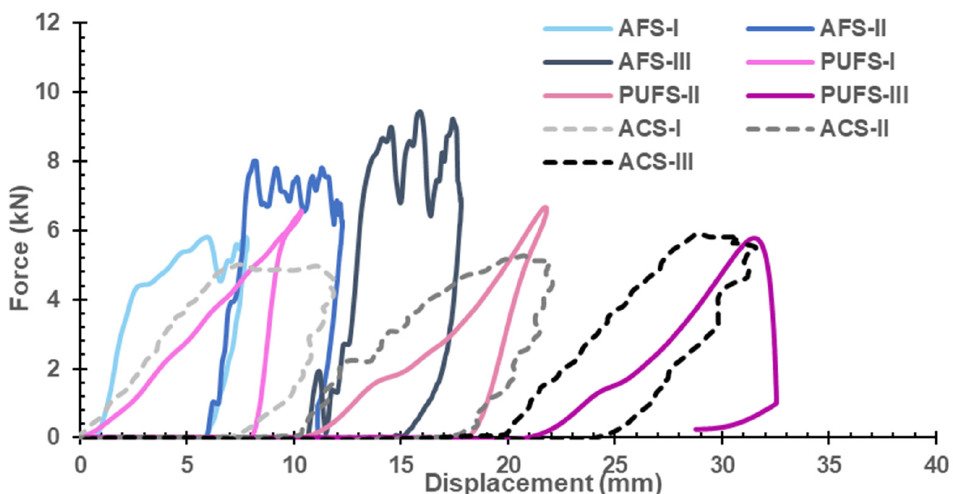
Figure 10. FE load–displacement curves of each impact for the multi-impact simulation.